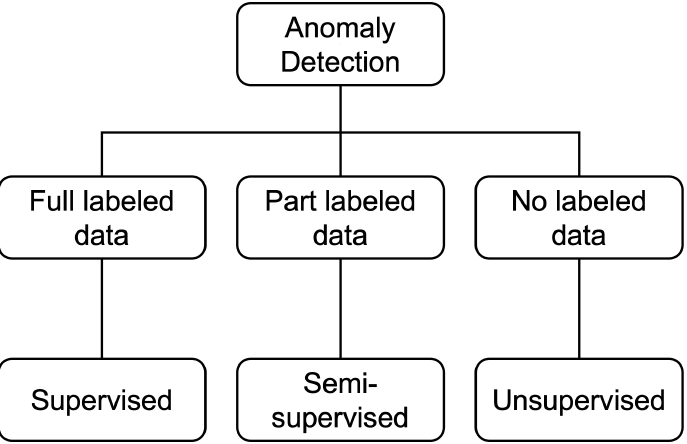
Figure 6. Deep-learning-based anomaly detection